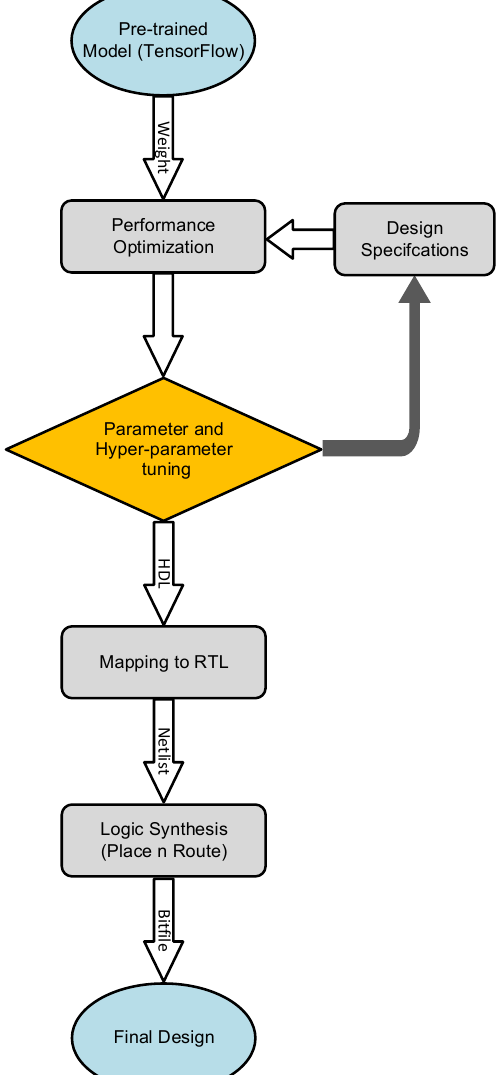
Figure 2. Flow chart of proposed CNN engine design.